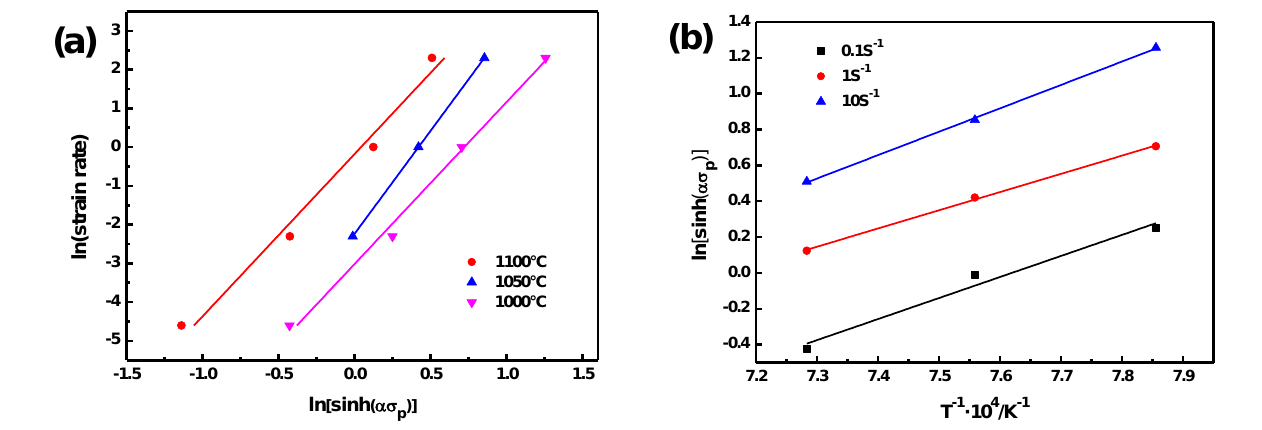
Figure 3. Relationship between: ( a ) ln[sinh(ασ p )] and ln 𝜀̇ , ( b ) ln[sinh( ασ p )] and 1/T. The equation below can be yielded, in accordance with Equations (1) and (2).